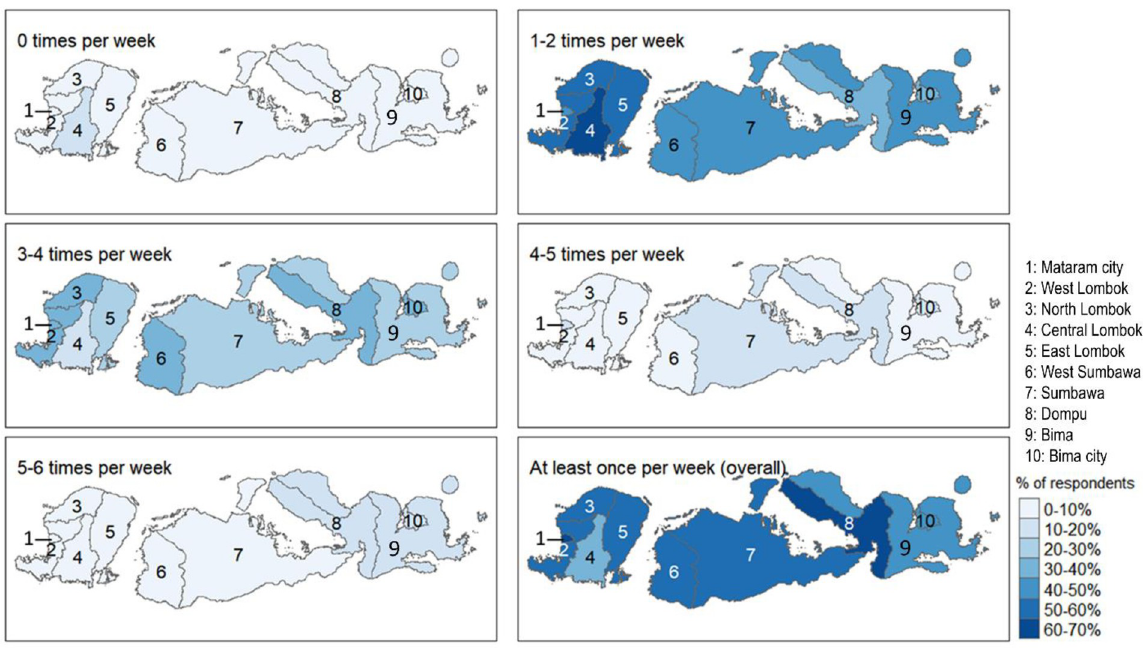
Fig 1. Frequency and distribution of fish consumption per week across regencies.